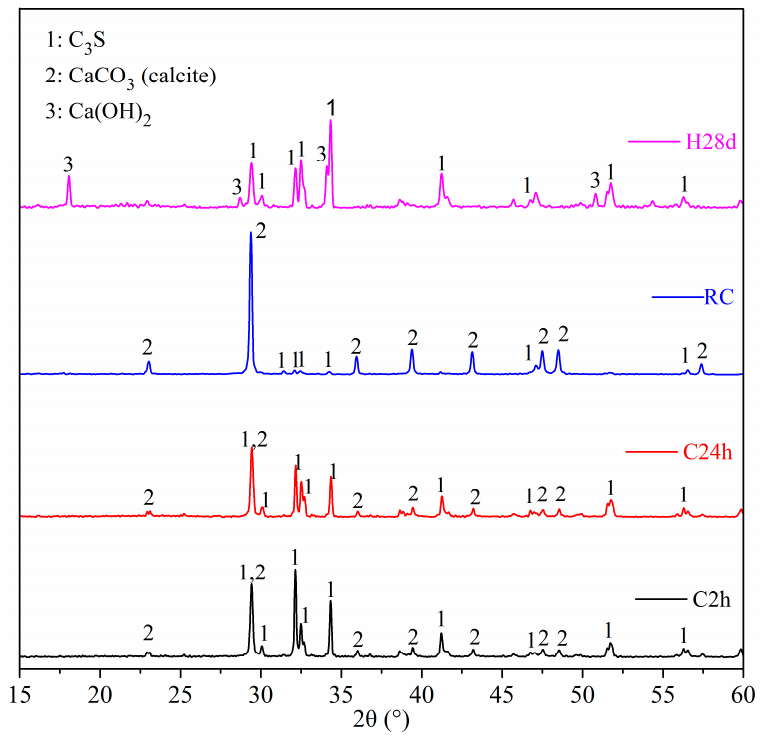
Figure 10. XRD pattern of carbonation and hydration samples.